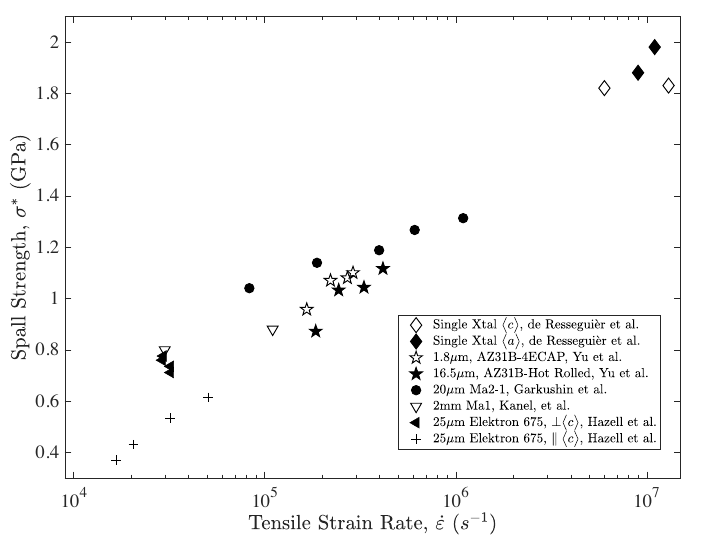
Figure 2. Spall strength as a function of tensile strain-rate determined from time-resolved velocimetry measurements on pure and alloyed Mg from the open literature. Reproduced or adapted from [41,107–110].